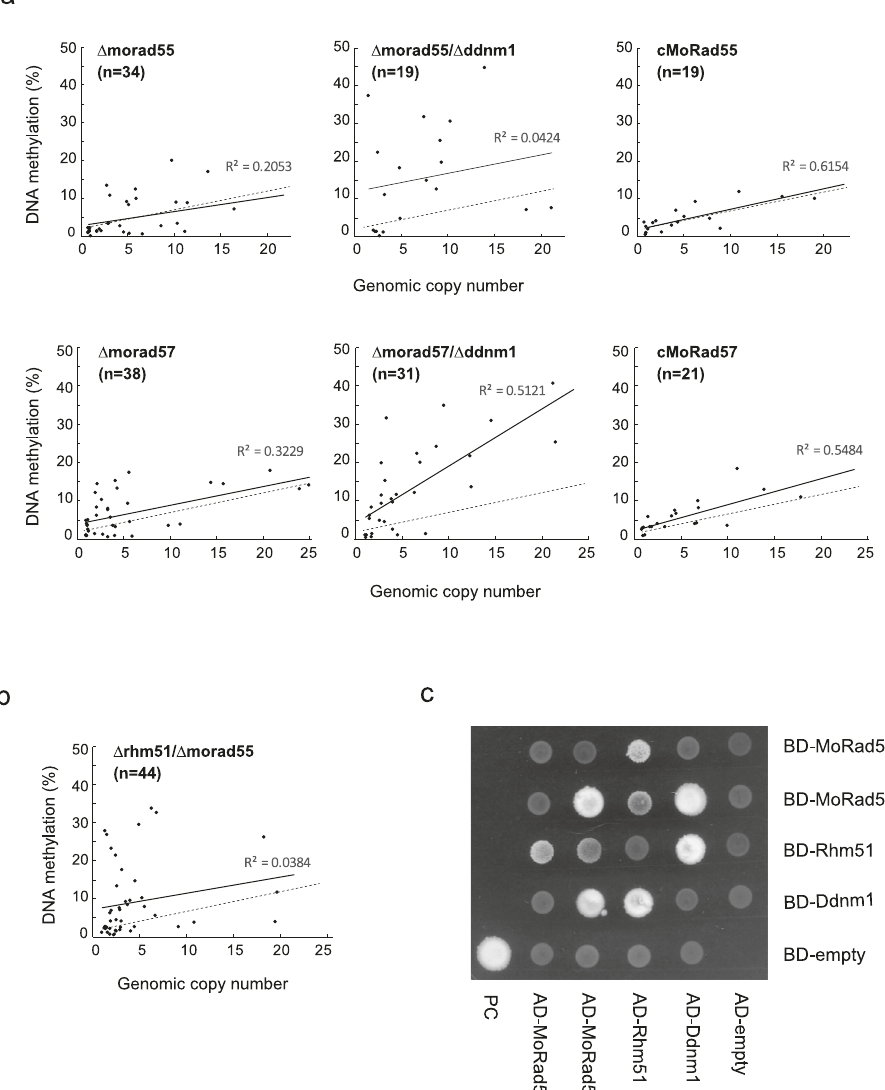
Fig. 4 Rad55 and Rad57 homologs in P. oryzae participate in copy number-dependent de novo DNA methylation of MAGGY. a Relationship between the genomic copy number and the rate of DNA methylation of MGY- Δ RT in the Δ morad55 and Δ morad57, and their double mutants with Δ ddnm1 as well as gene complementation strains (cMoRad55 and cMoRad57). The dashed line represents the regression line of the wild-type strain shown in Fig. 1a. b The same assay as in ( a ) was performed with a double deletion mutant of Rhm51 and MoRad55 . c Yeast two-hybrid assay for interaction among Ddnm1, Rhm51, MoRad55, and MoRad57, was performed using the constructs pGBKT7-53 with pGADT7-T as positive control (PC). Diploid yeast strains expressing each pair of hybrid proteins were grown to equivalent optical density (O.D.600 = 0.8) in 0.5x YPD liquid media, and spotted onto the SD/ – Leu/ – Trp/-Ade/ – His/ + AureobasidinA medium after 20-fold